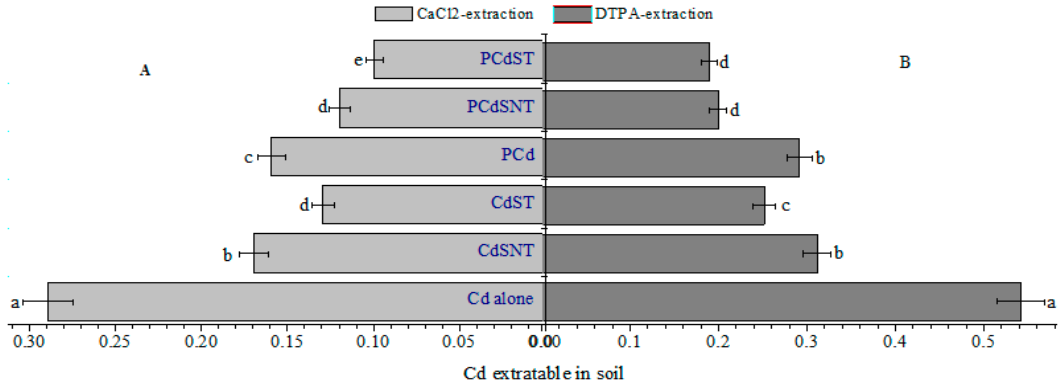
Figure 3. Effect of modified and unmodified rice straw on Cd extraction by CaCl 2 ( A ) and diethylenetriaminepentaacetic acid (DTPA) ( B ) in soil. In each group ( A and B ), the lowercase letters indicate a significant difference within different treatments (Tukey’tests, p < 0.001).